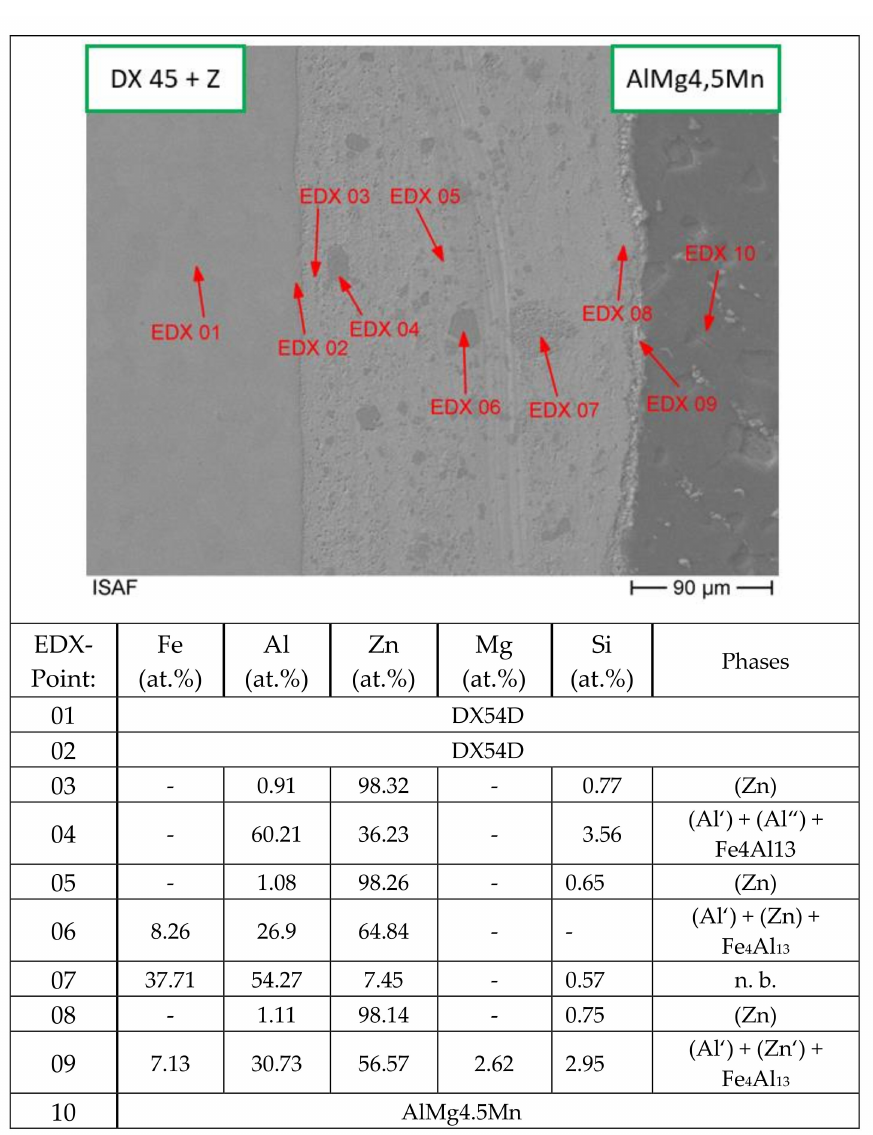
Figure 5. EDX analysis of the generated compound with pure zinc